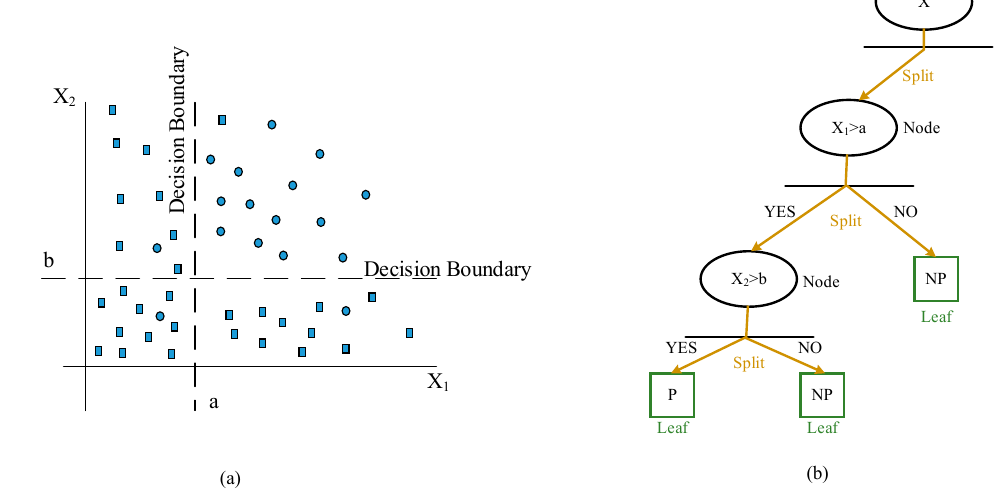
Figure 3. Two-feature classification: ( a ) a sample of classification result; ( b ) Binary decision tree for sample in ( a ).